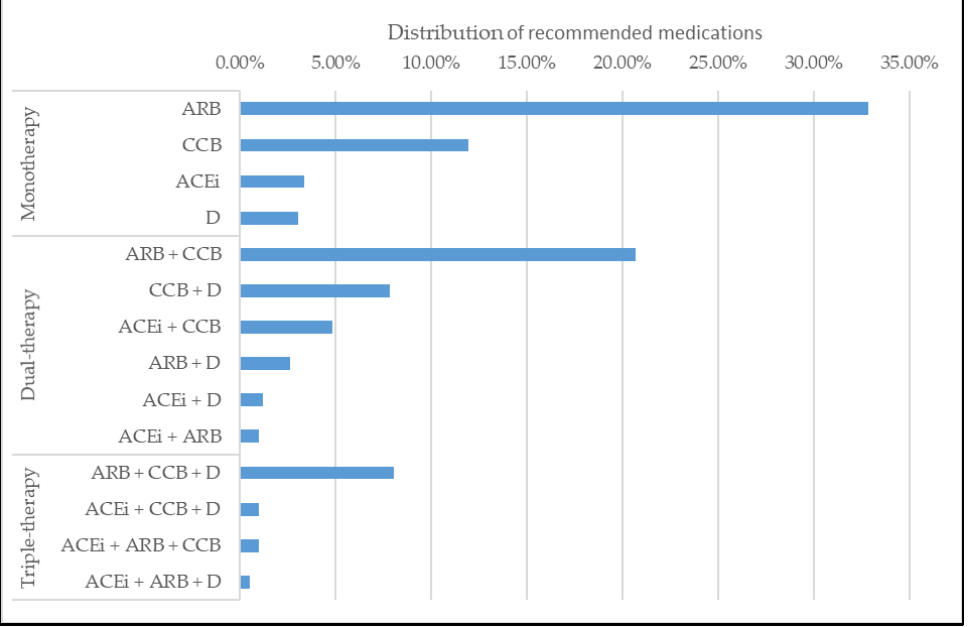
Figure 3. The trend of medication recommendations by each state component.